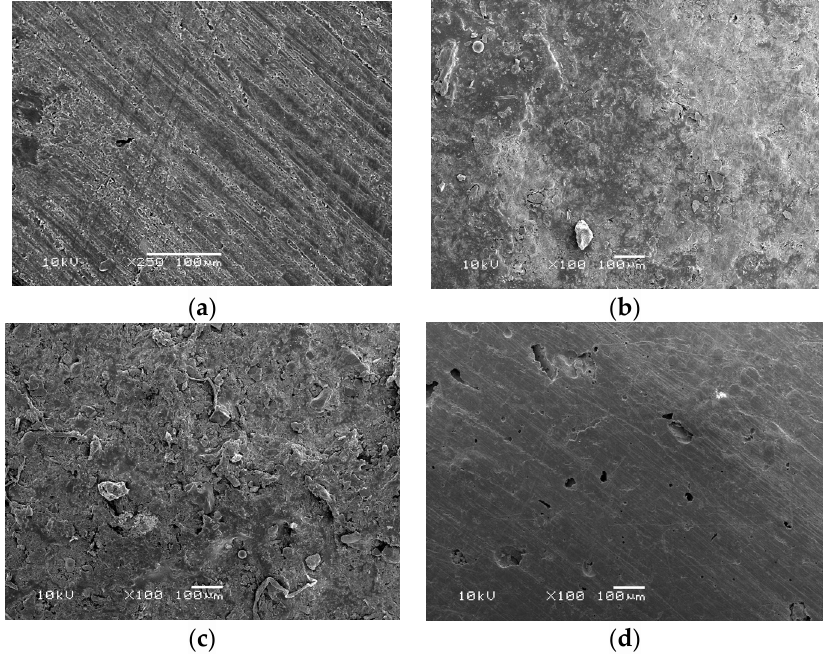
Figure 2. Scanning electron microscopy (SEM) showing surface roughness of acrylic samples mixed with: 0% MPC ( a ), 1.5% MPC ( b ), 3% MPC ( c ), and 4.5% MPC ( d ) as a protein repellent at 100 × magnification. HIPA acrylic resin with 4.5% MPC showed a surface roughness image comparable to that of the control group.